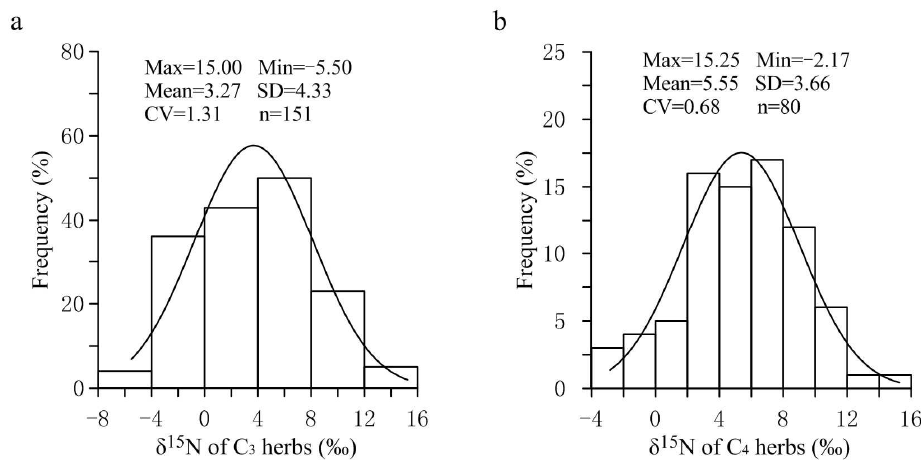
Figure 1. Frequency distribution of δ 15 N for C3 and C4 herbs in the study area. ( a ) Nitrogen isotopic frequency of C3 Herbs. ( b ) Nitrogen isotopic frequency of C4 Herbs.